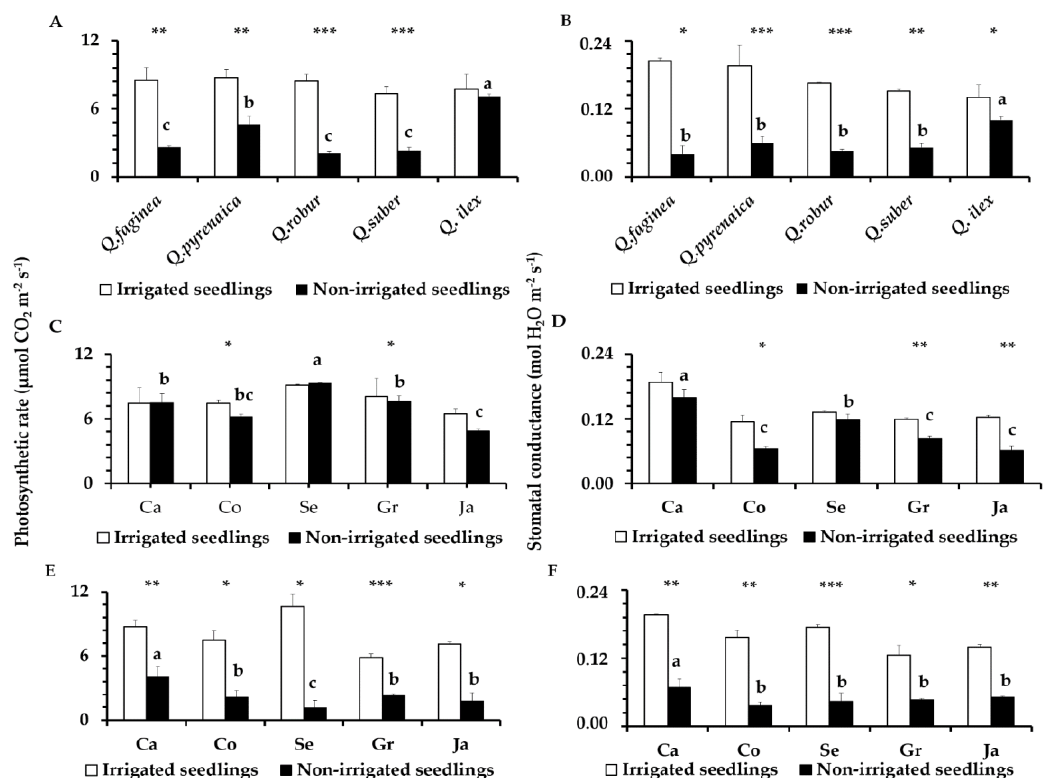
Figure 4. Photosynthesis rate, A, and stomatal conductance, Gs, in seedlings of the surveyed Quercus spp. and Andalusian Q. ilex populations, taken at day 9 (species ( A and B , respectively) and populations ( C and D , respectively) and day 21 (populations ( E and F , respectively)). Values are mean ± SE of three biological replicates. Asterisk indicates significant di ff erences between treatments (* p < 0.05; ** p < 0.01; *** p < 0.001). In the non-irrigated seedlings, the same letter indicates that there is no significant di ff erence between species or populations ( p = 0.05).